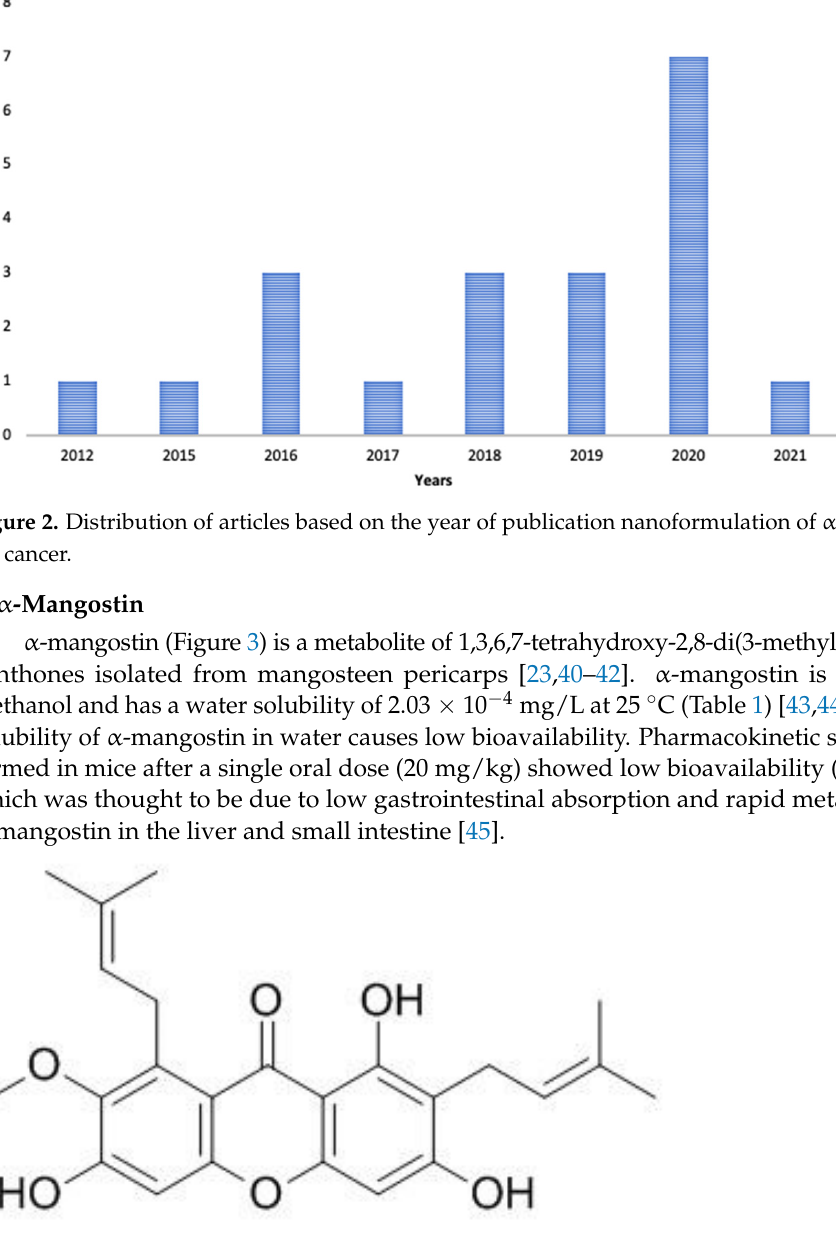
Figure 1. Flowchart of methodology.